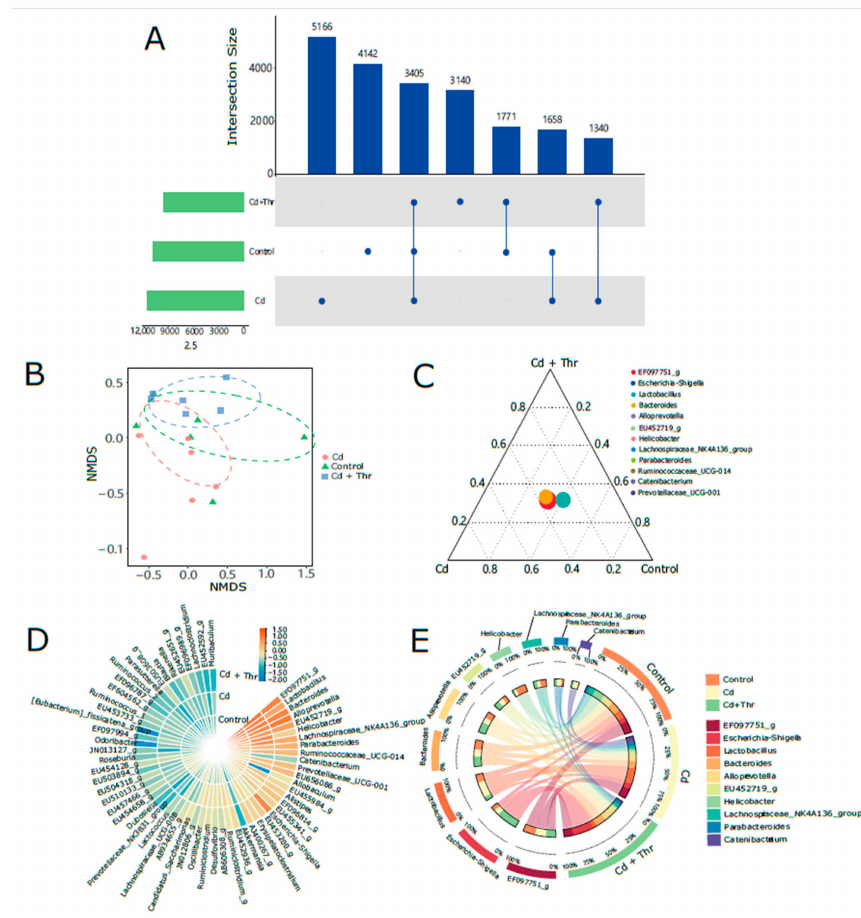
Figure 3. Effects of Thr on GM in mice. ( A ) The result of 97% similarity of operational taxonomic units (OTUs) was described in the UpSet diagram of the control, Thr-treated, and Cd-treated groups. The dotted circles beneath the bar chart indicate the group that contains the same OTU. ( B ) The differences in microbiota structure were described in non-metric multidimensional scaling analysis (NMDS) maps. The distance between the two communities was specified using the weighing of UniFrac. ( C ) The gut microbial component at the genus level was analyzed with a Ternary Plot diagram. ( D ) The microbial abundance heatmap at the genus level. ( E ) Circos graph represented the composition of GM at the genus level. The abundance of the top 10 bacteria was chosen to demonstrate the structure of